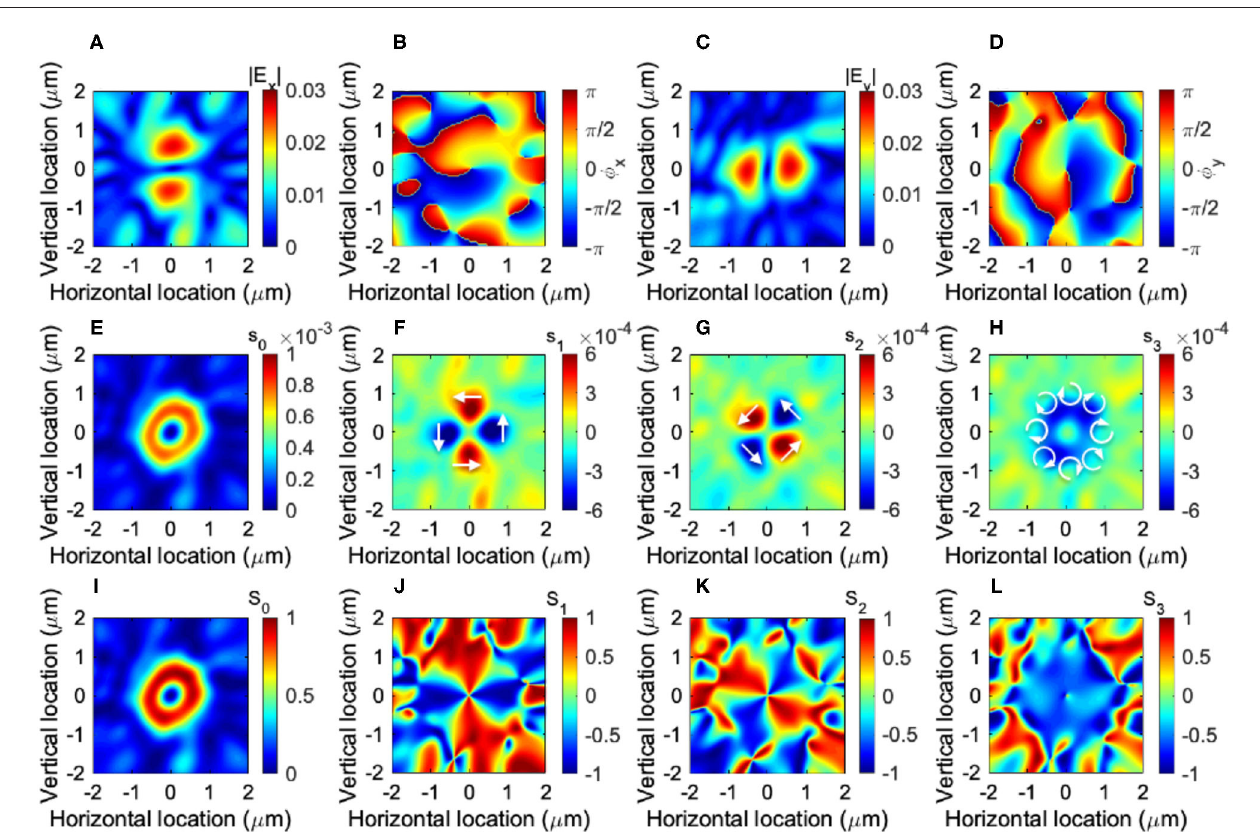
FIGURE 3 | Left vortex generated from the gear of N 10. The input port 1 is used to inject photons to the waveguide, and the mode profile is obtained at z = E x above the gear. (A) The amplitude ( ) and (B) the phase ( φ x ) of the horizontal electric field E x . (C) The amplitude ( | | iE x field E y . They show E y e i φ , showing the direct tensor product state of the right-circularly-polarized state and the left-vortexed state, ∼ − ∝ (E) The local intensity, s 0 , (F) local horizontal/vertical spin component, s 1 , (G) local diagonal/anti-diagonal spin component, s 2 , and (H) local left/right spin component, s 1 . Normalized Stokes parameters of (I) S 0 , (J) S 1 , (K) S 2 , and (L) S 3 . White arrows in (F–H) schematically show the direction of